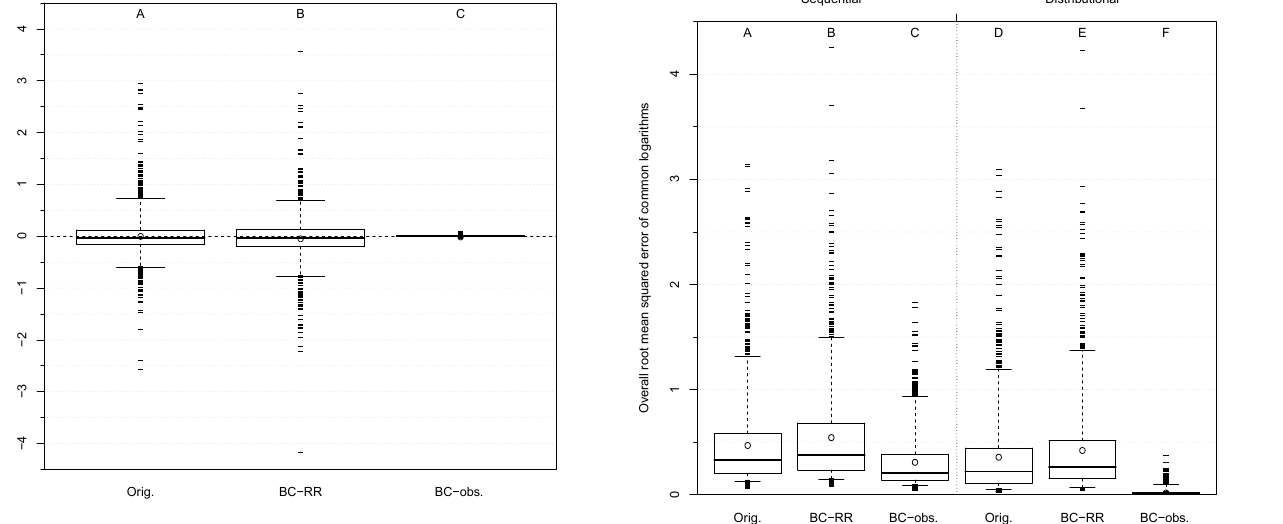
Figure 4. Distribution of logarithmic accuracy, measured as the root mean squared error between the common logarithms of observed and simulated streamflow at 1168 streamgages across the contermi- nous USA. Orig. refers to the original simulation with pooled ordi- nary kriging, BC-RR refers to the Orig. hydrograph bias-corrected with regionally regressed flow duration curves, and BC-Obs. refers to the Orig. hydrograph bias-corrected with observed flow dura- tion curves. Sequential indicates that contemporary days were com- pared, while distributional indicates that days of equal rank were compared. The tails of the box plots extend to the 5th and 95th per- centiles of the distribution; the ends of the boxes represent the 25th and 75th percentiles of the distribution; the heavier line in the box represents the median of the distribution; the open circle rep- resents the mean of the distribution; outliers beyond the 5th and 95th percentile are shown as horizontal